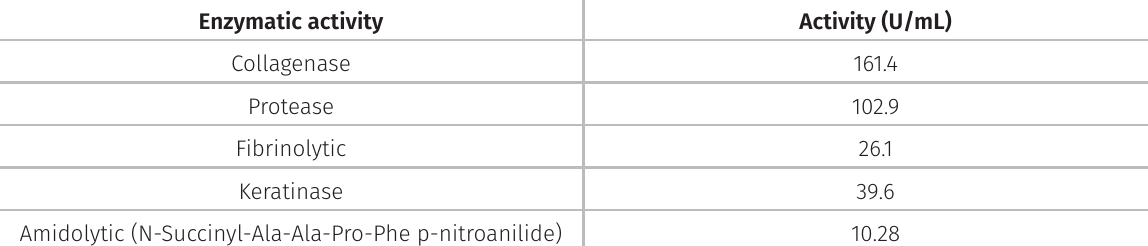
Table I. Enzymatic activities measured in the crude extract obtained by Mucor subtilissimus UCP